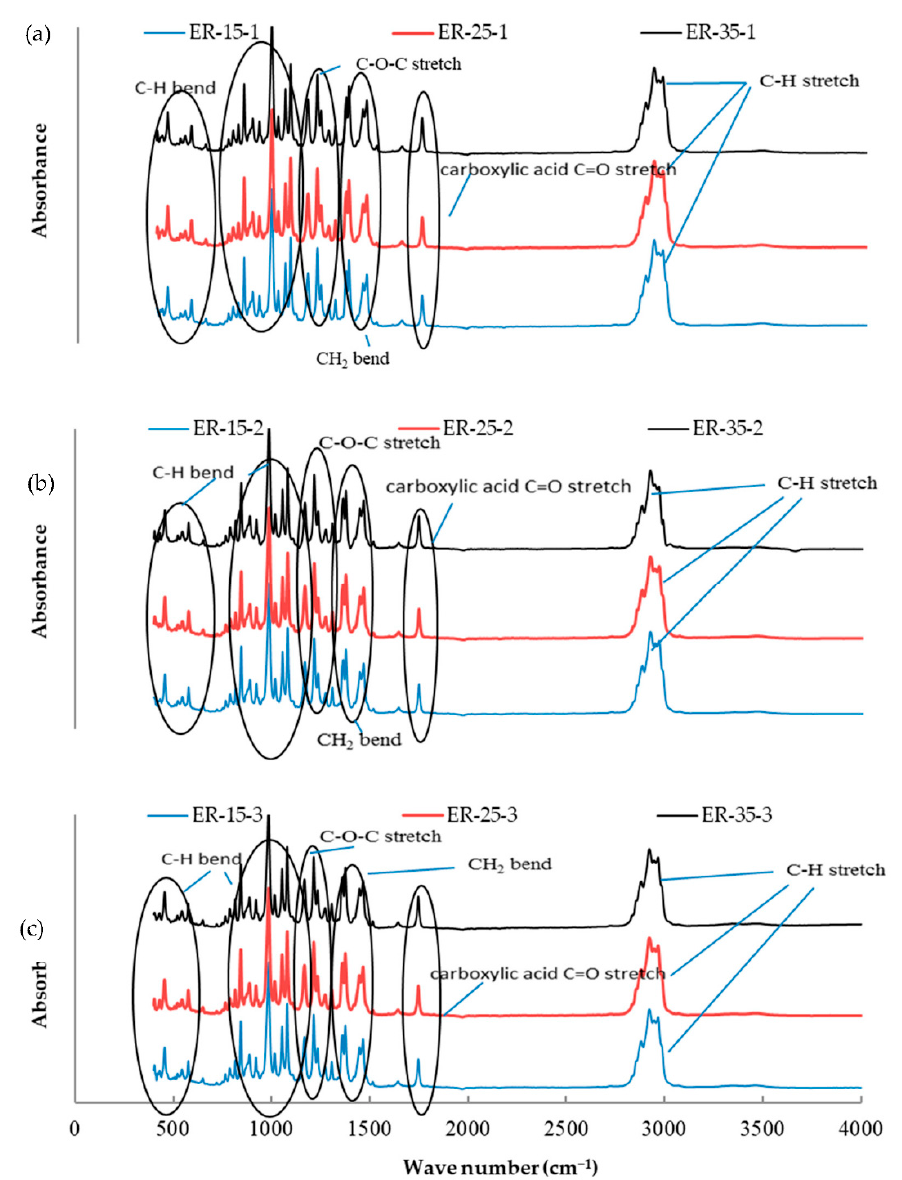
Figure 4. Fourier-transform infrared spectroscopy (FTIR) analysis for the essential oil combination of eucalyptus + rosemary (ER) at different temperatures (15, 25, and 35 °C) and different times of storage (1–3 months) (different colors refer to different temperature per subfigure). ( a ) This figure refer to the effect of different temperature at 15, 25, and 35 °C on the combination of ER stored for one month; ( b ) the second subfigure refer to different temperature at 15, 25, and 35 °C on the combination of ER stored for two months; ( c ) the third subfigure refer to different temperature at 15, 25, and 35 °C on the combination of ER stored for three months.